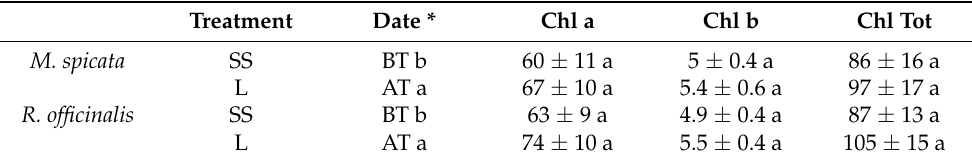
Table 4. Chlorophyll (Chl) a and b, and total (mg · mL − 1 ) content in M. spicata and R. officinalis plants under different nutrient sources in two times before (BT) and after (AT) application of vermicompost leachate and inorganic